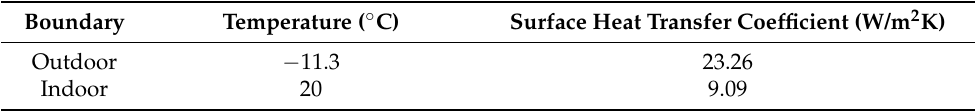
Table 1. Boundary conditions for simulation.